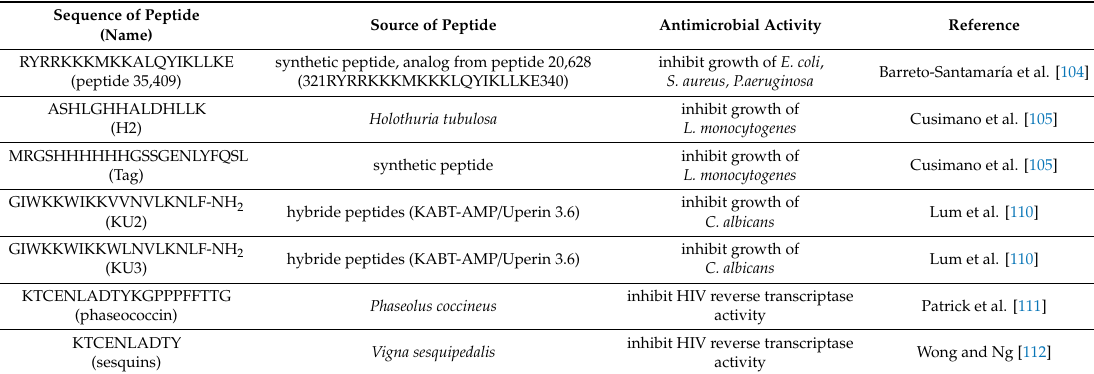
Table 3. Peptide sequence with antimicrobial